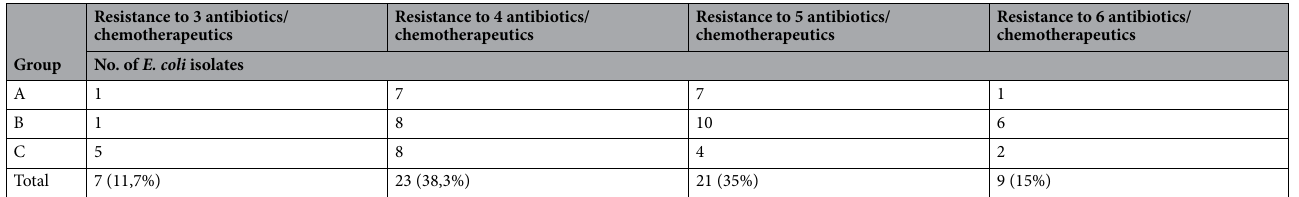
Table 1. Resistance profiles of multi-drug resistant E. coli